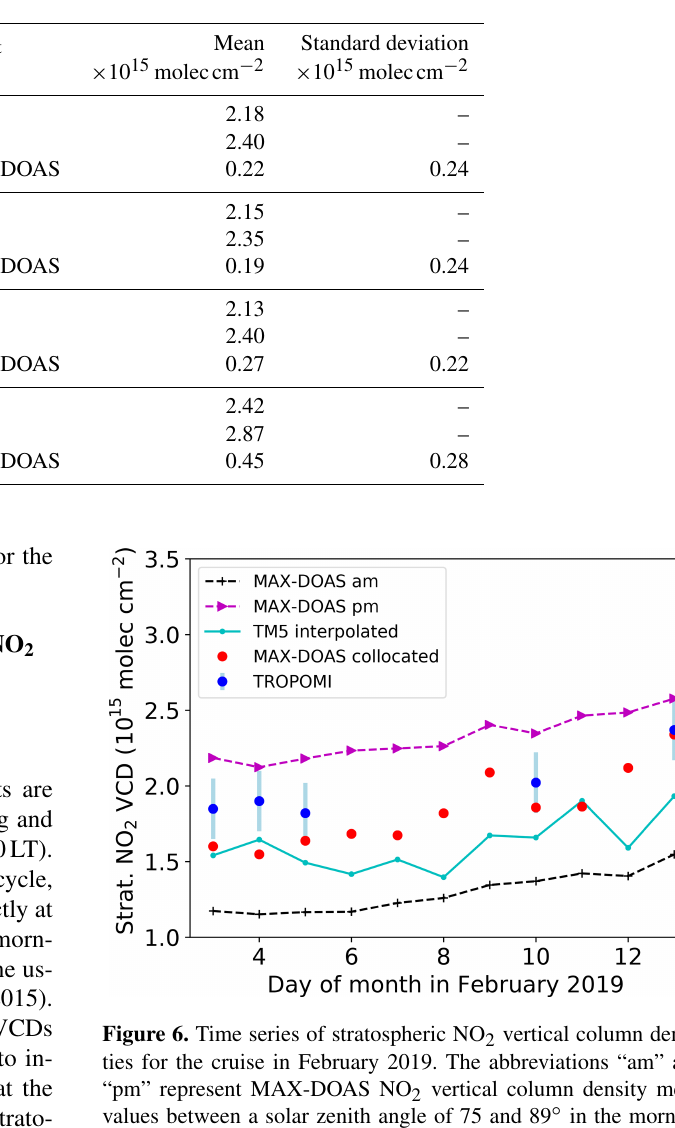
Table 2. Statistic results of the comparison of TM-5 and MAX-DOAS stratospheric NO 2 vertical column densities.